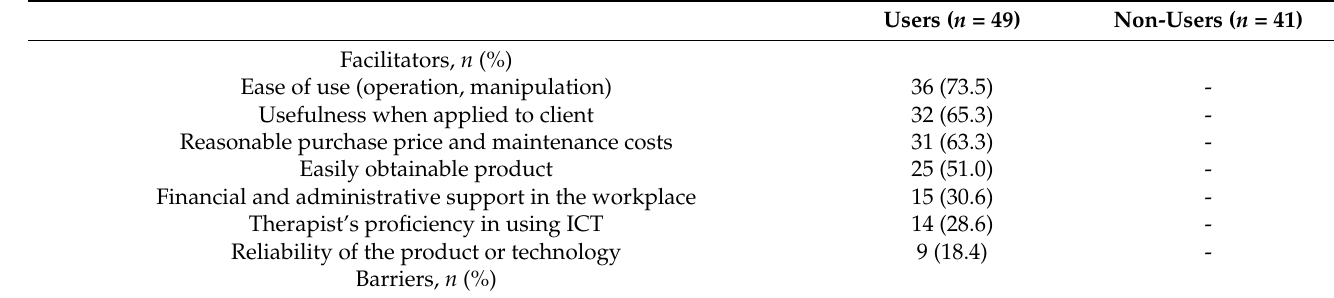
Table 3. Facilitators and barriers to ICT use in clinical practice among familiar OTs ( n = 177).